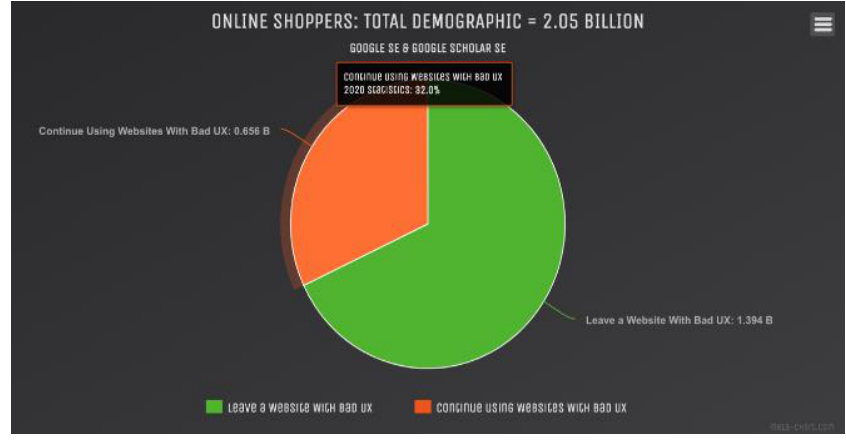
Figure 1: E-Commerce User's Web Behaviour